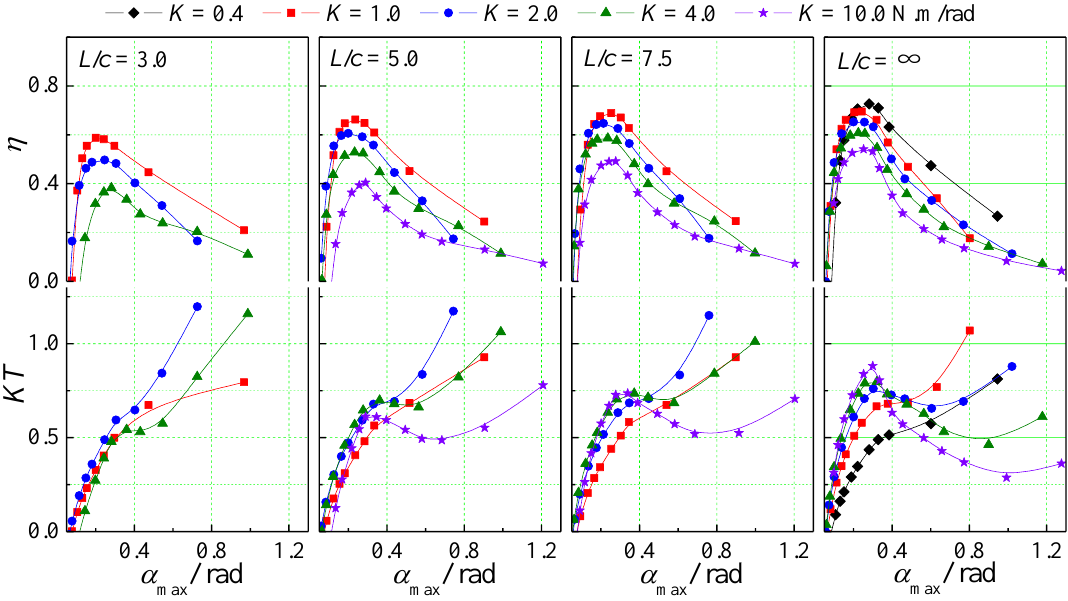
Figure 11. Propulsive performance with different spring stiffness and swing arm lengths.